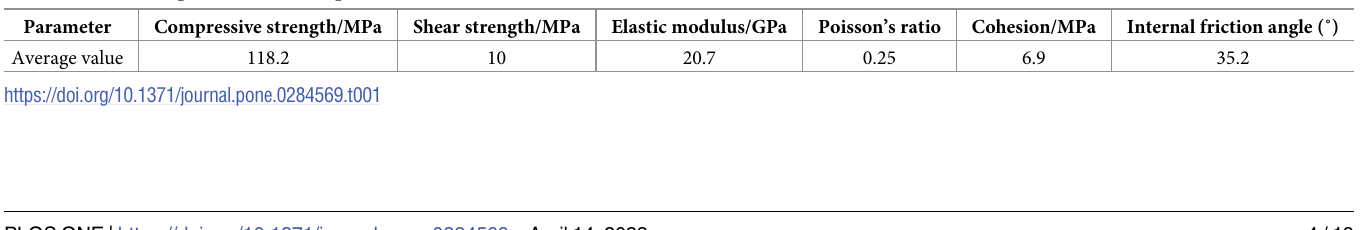
Table 1. Mechanical parameters of the